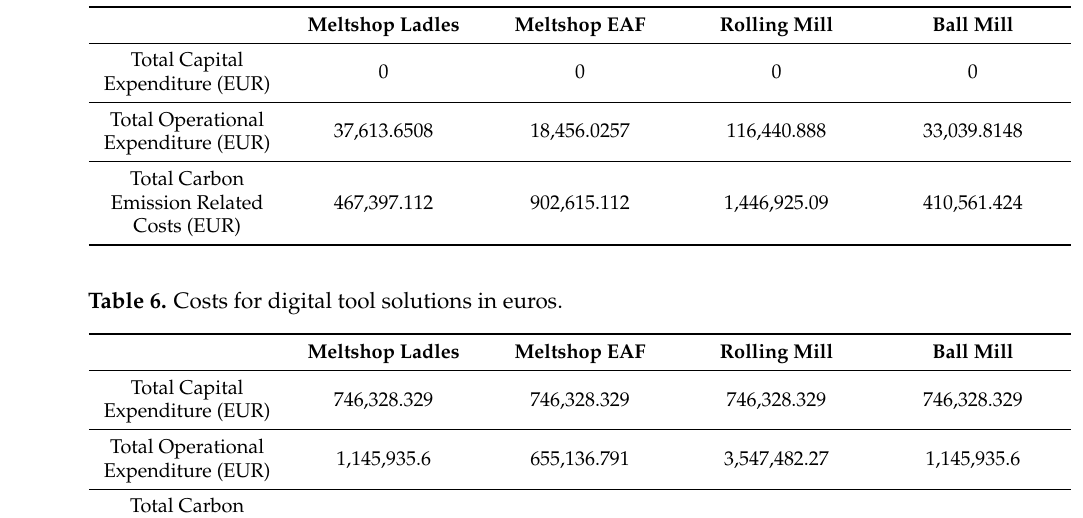
Table 5. Cost for the reference scenario in euros.